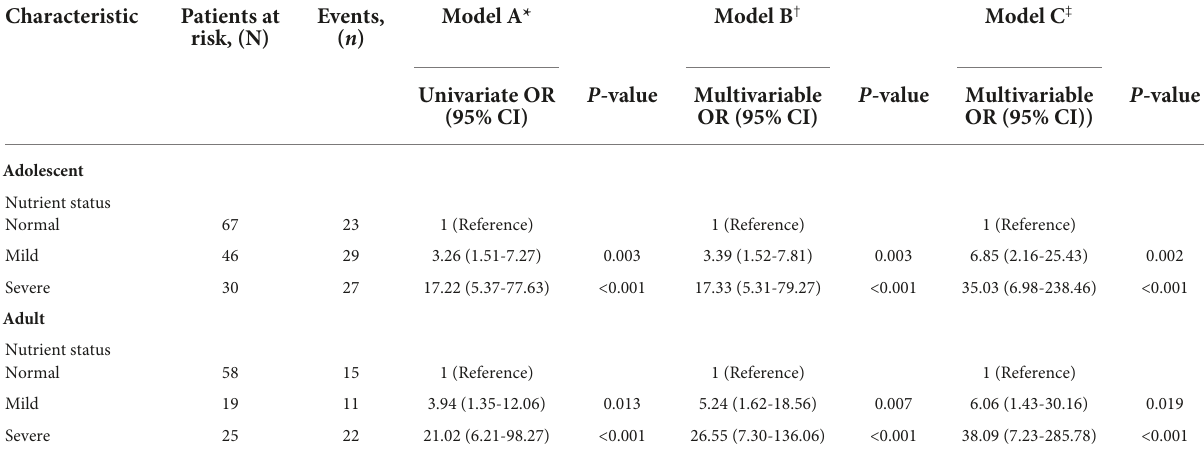
TABLE 2 The associations between the nutritional status and the risk of LP in patients with osteosarcoma during chemotherapy ( n = 245). Characteristic Patients at risk, (N)